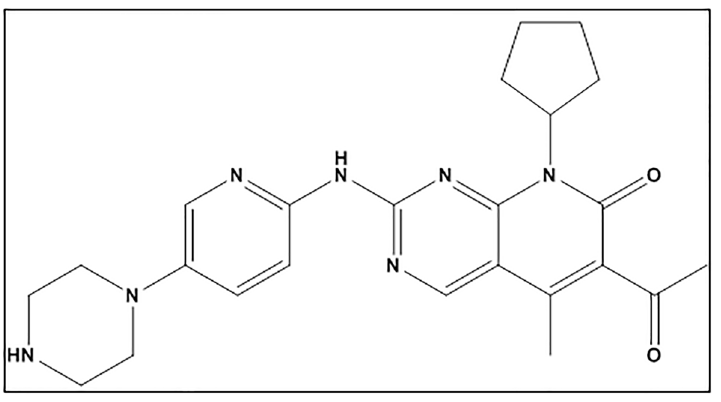
Figure 1. Chemical structure of